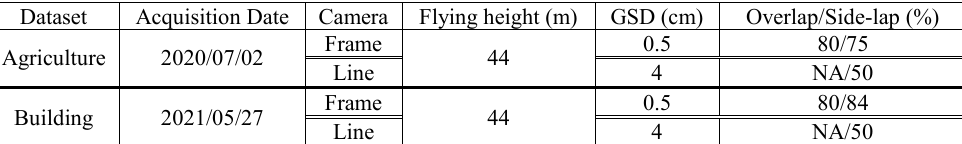
Table 1. Data collection dates, flying height, GSD, and overlap/side-lap for the two datasets used in this